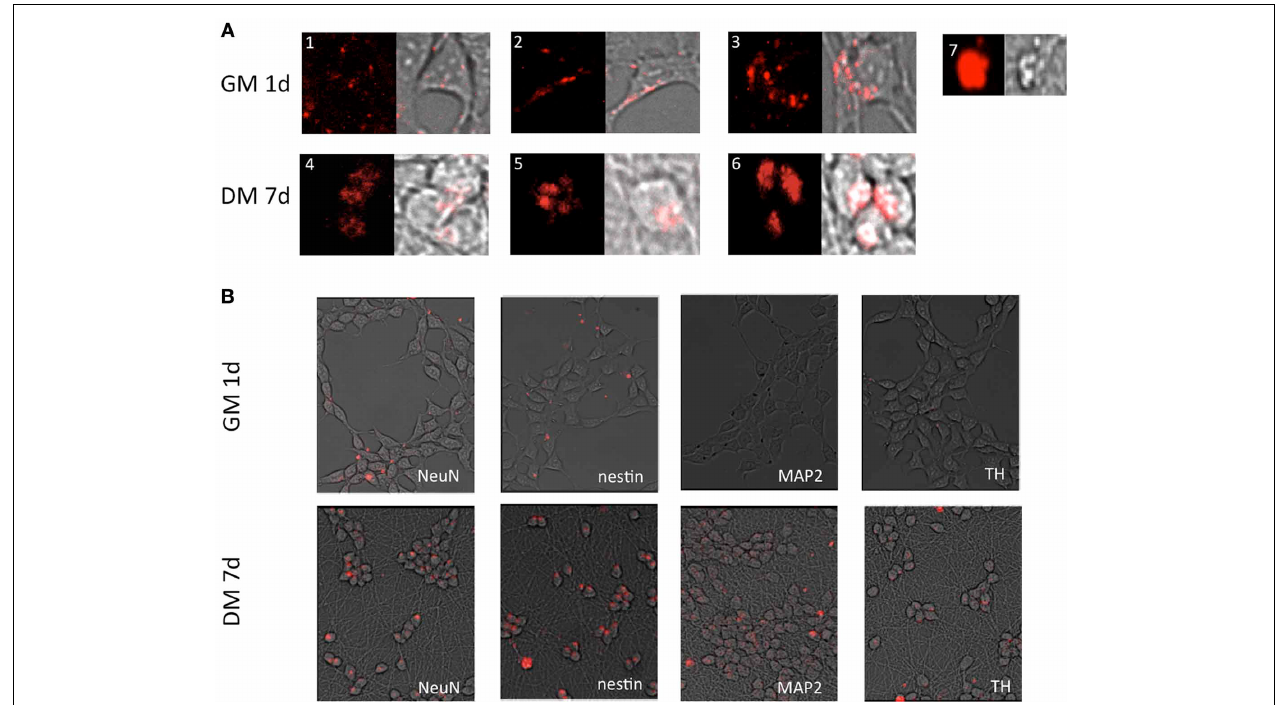
FIGURE 4 | Fluorescent images of cells transfected with MBs. (A). Different MB signal patterns observed in LUHMES cells grown in GM 1 day after transfection ( A1–3 ) and 7 days post induction of differentiation ( A4–6 ). ( A7 ) shows large bright fluorescent clusters originating from apoptotic cells